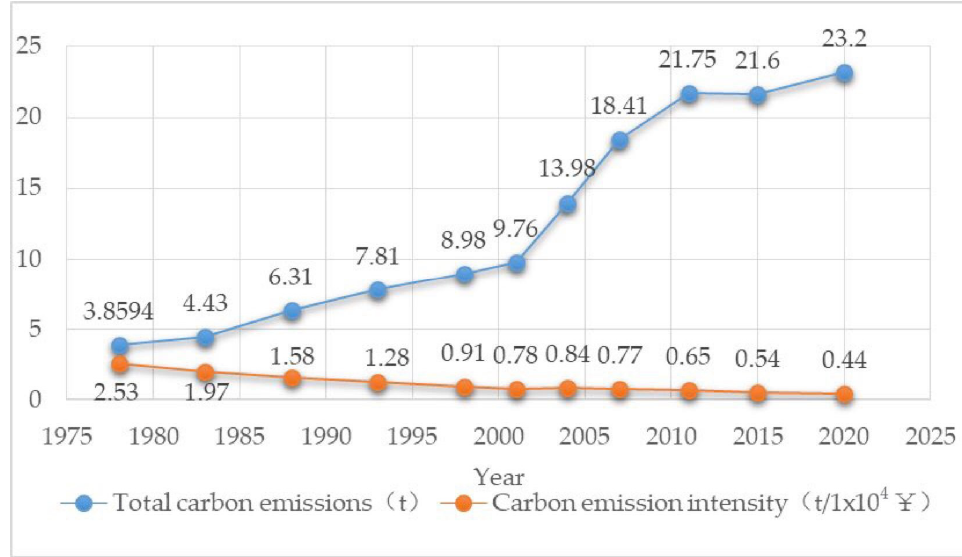
Figure 4. Trend of total carbon emissions and carbon intensity in China.